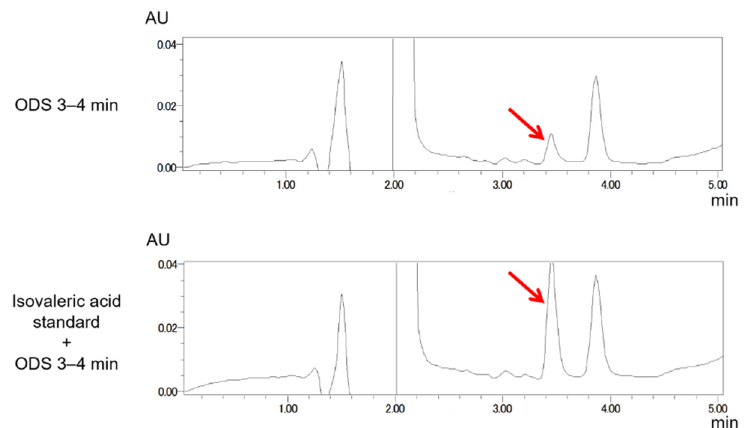
Figure A4. A peak in the fraction ODS (3–4 min) exhibiting plant growth inhibiting activity co-